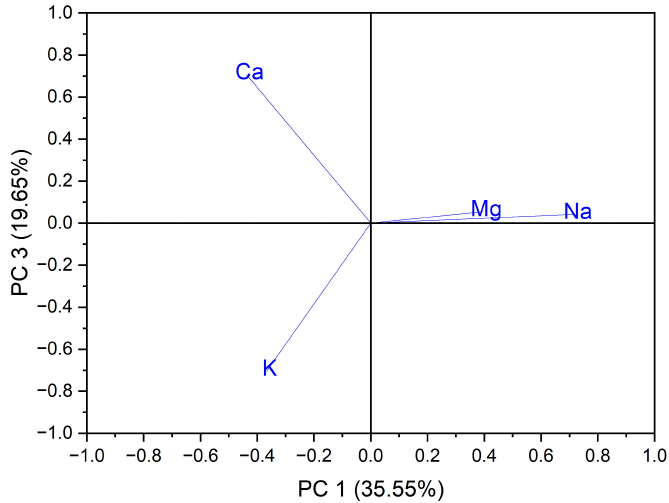
Figure 2. Chart of records of PC3 vs. PC1 for PCA analysis, using as input data the content of macro elements for the analyzed vegetable samples.